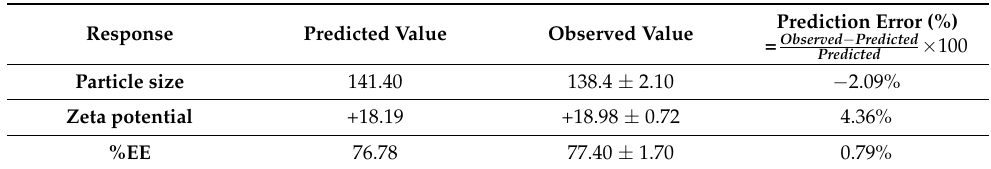
Table 5. Predicted and observed response of CUR/LCSNPs with maximum desirability suggested by the Box-Behnken statistical design.